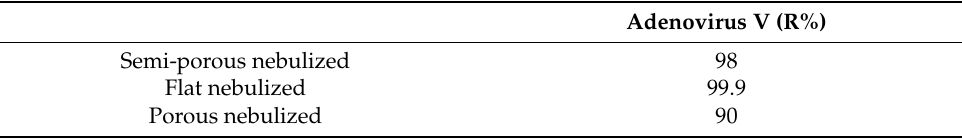
Table 4. Percentage values of plaque reduction after nebulization with hypochlorous solution at 300 ppm on different surfaces contaminated with Adenovirus V. All the data reported are the average of three independent experiments conducted (each experiment) in